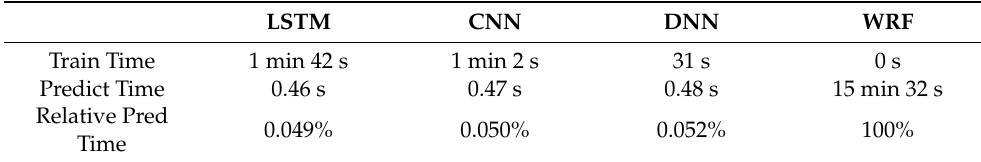
Table 2. Training time and prediction time for different